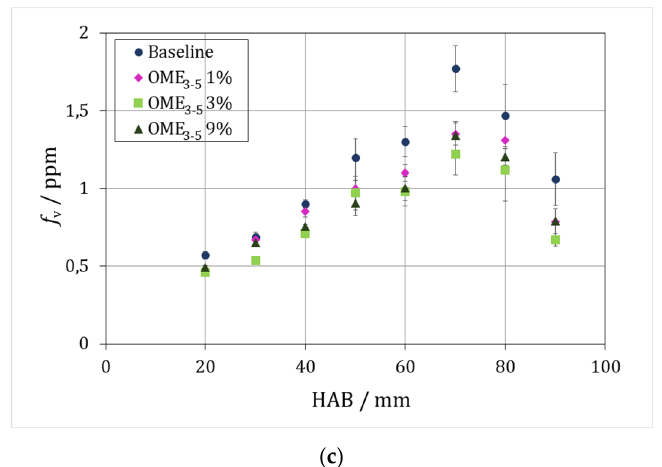
Figure 7. Vertical f V trends for ( a ) Baseline and TPGME–diesel blends (1% vol, 3%vol and 9% vol) ( b ) baseline and OME 2 –diesel blends (1% vol, 3%vol and 9% vol) and ( c ) baseline and OME 3–5 –diesel blends (1% vol, 3%vol and 9% vol). Error bars represent standard deviation of approx. 1000 single-shot results.